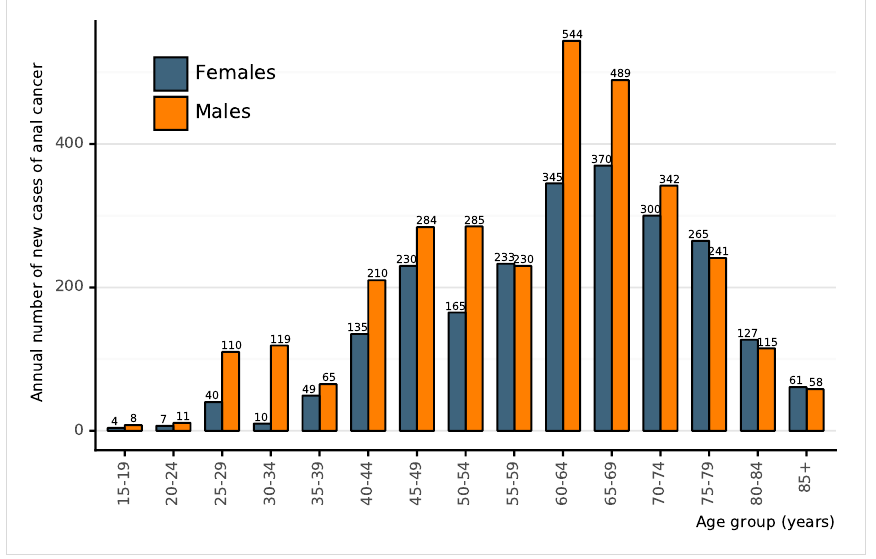
Figure 16: Annual number of new cases of anal cancer in India (estimates for